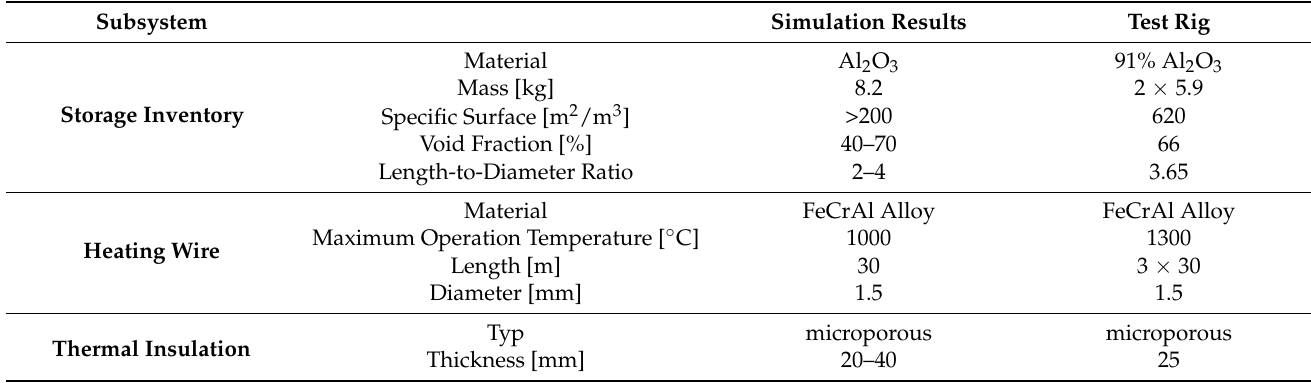
Table 1. Central specification for the favorite design solution: simulation results vs. test